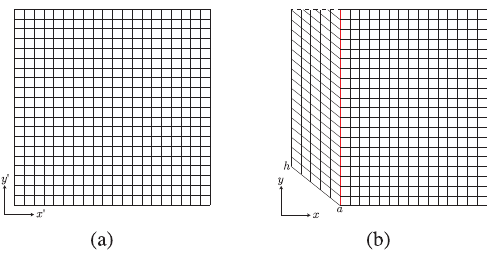
Fig. 1. Isovolumetric transformation. (a) Original coordinate system of the fi rst quadrant space. (b) Transformed coordinate system creating the triangular space in the bottom left corner.